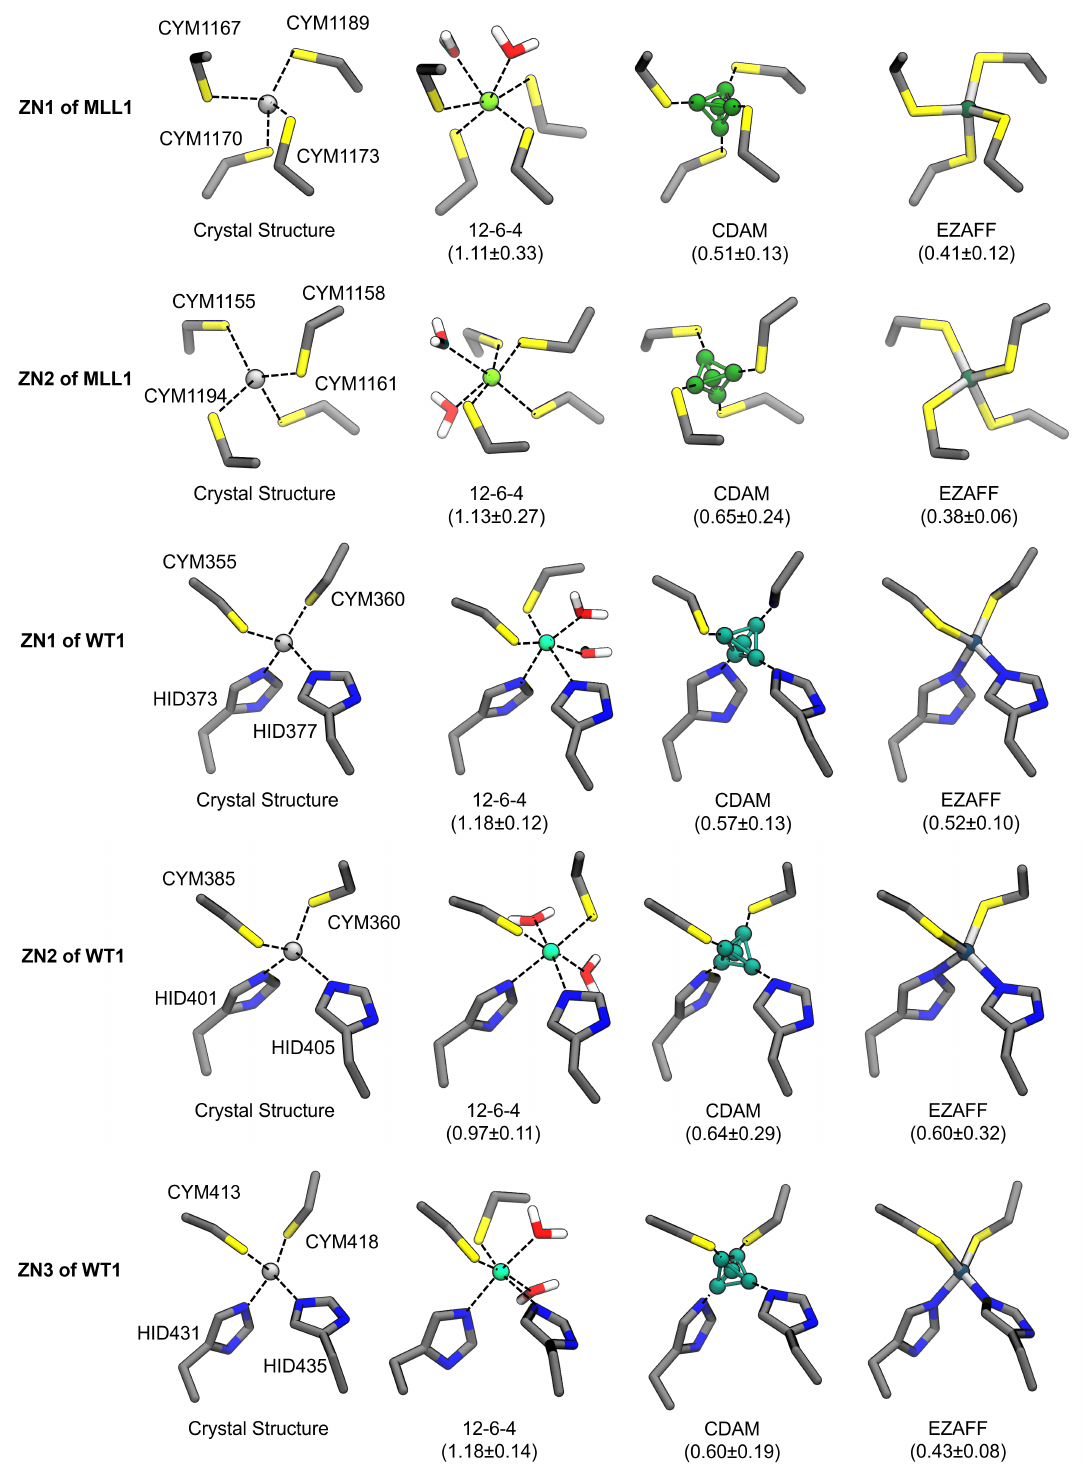
Figure 6. Coordination geometries of all Zn 2 + -ions in MLL1 and WT1, respectively, as observed in the crystal structures and MD simulations with the different ion models (shown as representative median structures). Average RMSD values with respect to the crystal structure in Å are shown in parentheses. Hydrogen atoms are not shown for clarity. For corresponding residue indices, see Table